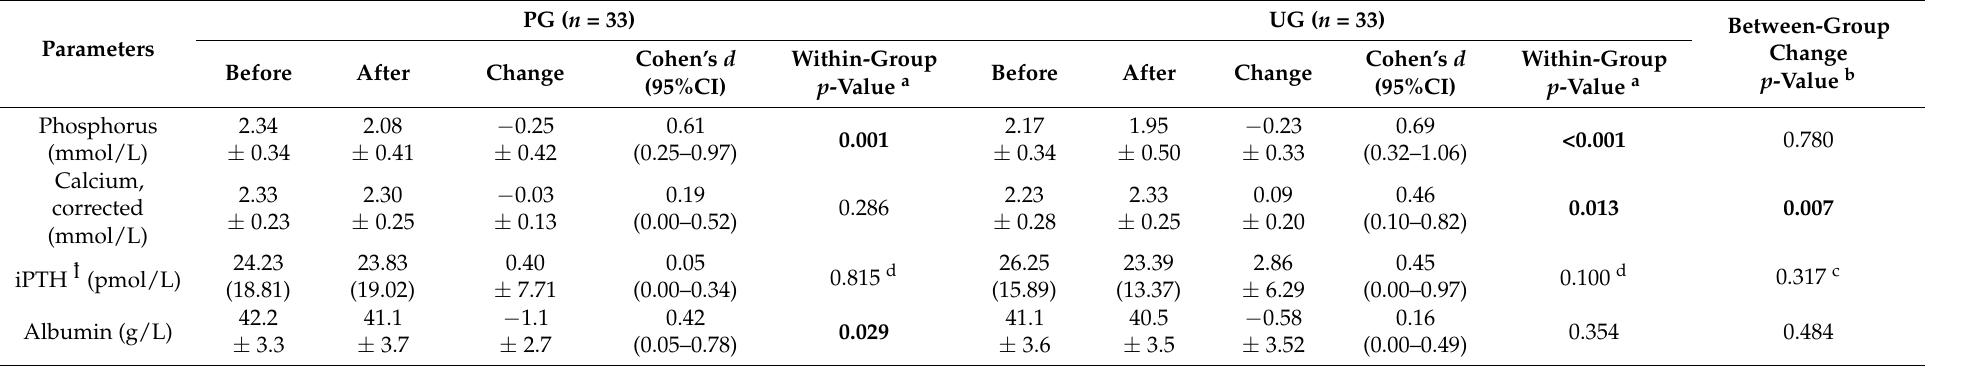
Data are presented as median (interquartile range). a Paired-samples t -test,